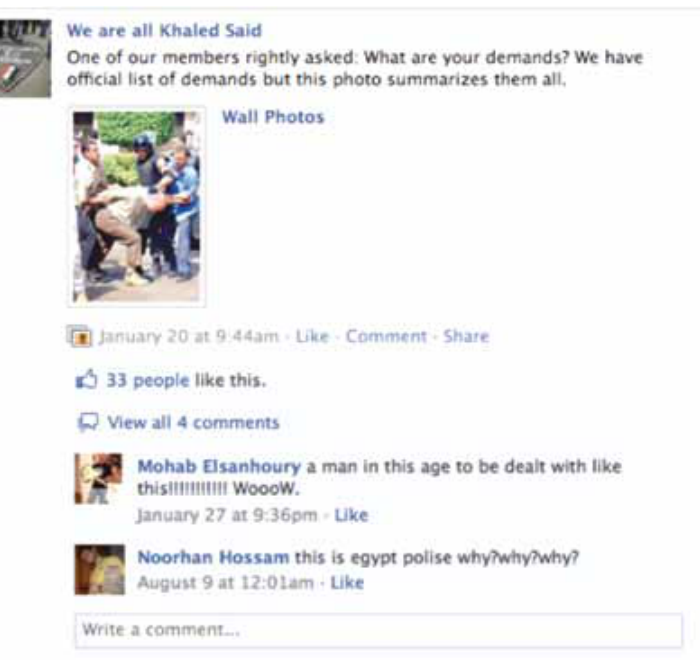
Figure 4: Snapshot of WAAKS English, 20 January 2011